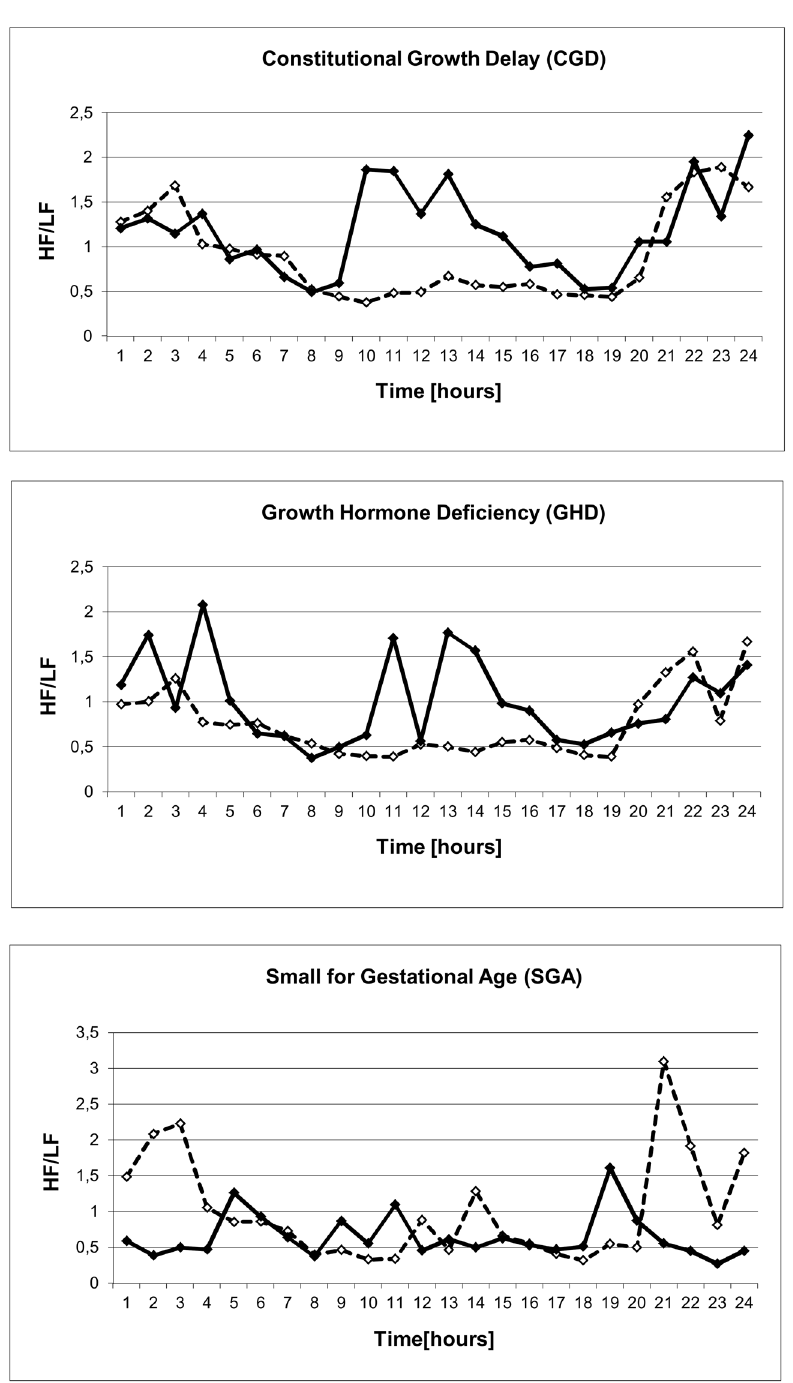
Fig 2. Effect of clonidine on HF/LF in normal and short stature children. Effect of clonidine given at 9:00 a.m. on the autonomic balance indicated by the parameter HF/LF compared to baseline data of age-matched healthy controls( ^ ). Children with constitutional growth delay (n = 36) show a clear rise of HF/LF ratio indicating sympathetic inhibition ( ♦ ). The effect is smaller in growth hormone deficient children (n = 14) and absent in children small for gestational age (n = 6) ( ♦